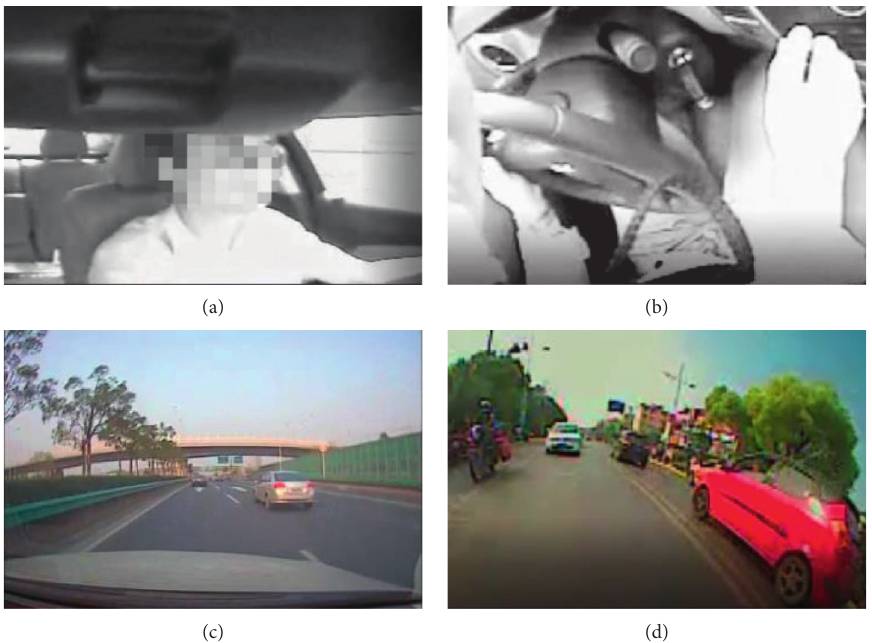
Figure 3: Four cameras for the SH-NDS DAS. (a) Driver monitor. (b) Hand monitor. (c) Forward roadway. (d) Rear In Figure 5, rectangles represent observed variables; ellipsoids represent unobserved latent factors, and arrows from the observed variables to latent factors represent re- gression paths. Additionally, circles with arrows pointing toward each observed variable represent measurement error.